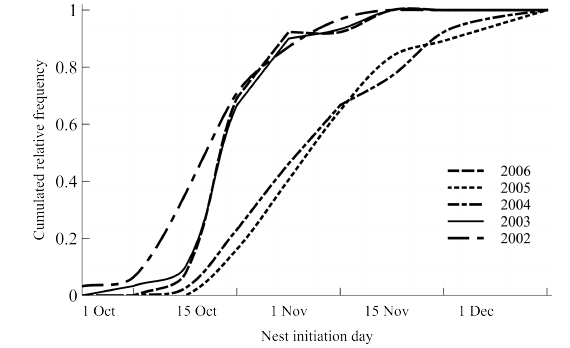
Fig. 1 . Temporal distribution of nest initiation of Turquoise- fronted Parrot ( Amazona aestiva ) at Loro Hablador Provincial Park in northern Argentina during the 2002–2006 breeding seasons. Curves represent the cumulated relative frequency of the percentage of total nests initiated in a given